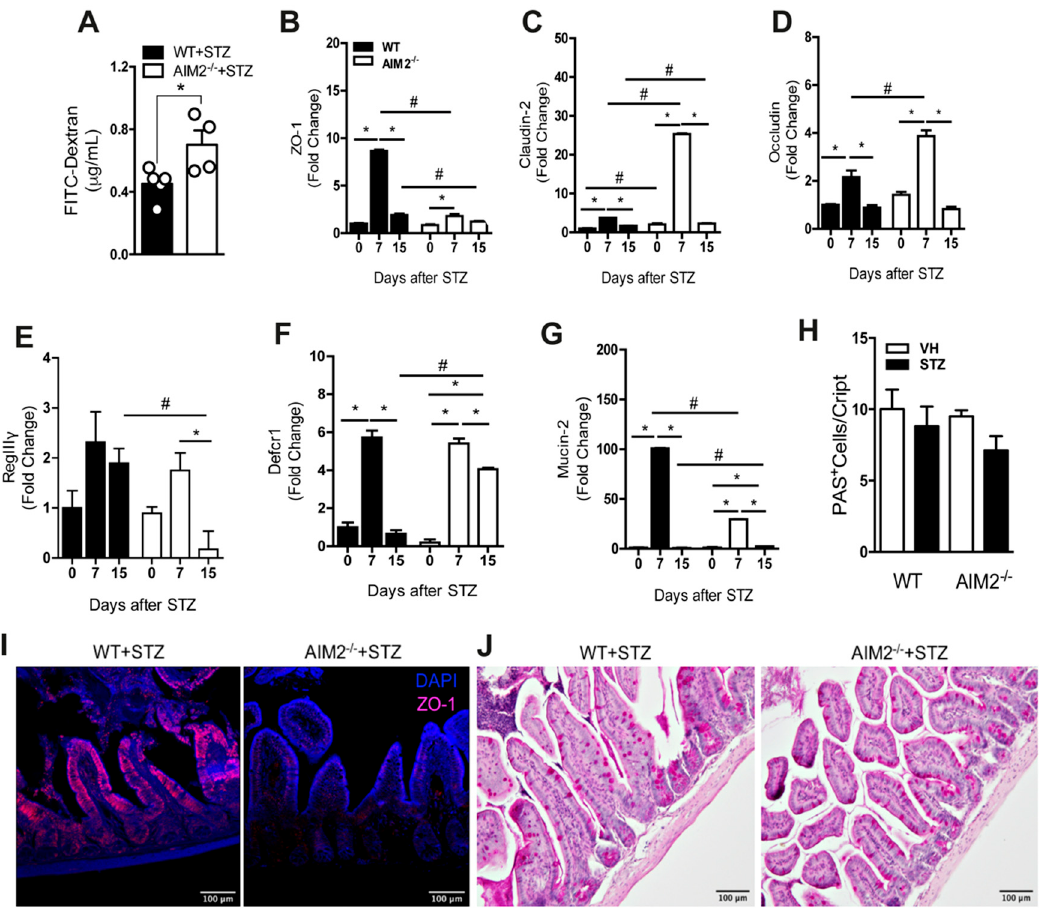
Figure 6. AIM2 receptor regulates the intestinal barrier function to control gut permeability during T1D. ( A ) FITC-dextran levels in the serum of the WT and AIM2 − / − mice at 15 days after the STZ injections. ( B – G ) The gene expression of ZO-1, claudin-2, occludin, RegIII γ , Defcr1, and mucin-2, respectively, in the small intestine of the WT and AIM2 − / − mice at 0, 7 and 15 days after the STZ or